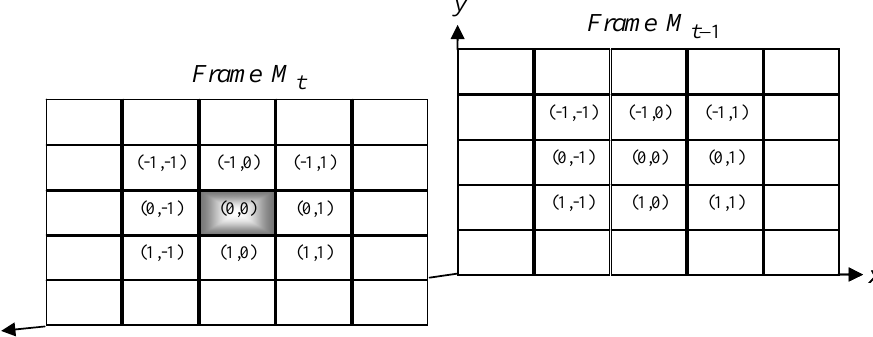
Fig 1: Spatiotemporal neighbourhood of point )0,0( t M . The temporal and spatial neighbouring points are in frames 1 − t M and t M